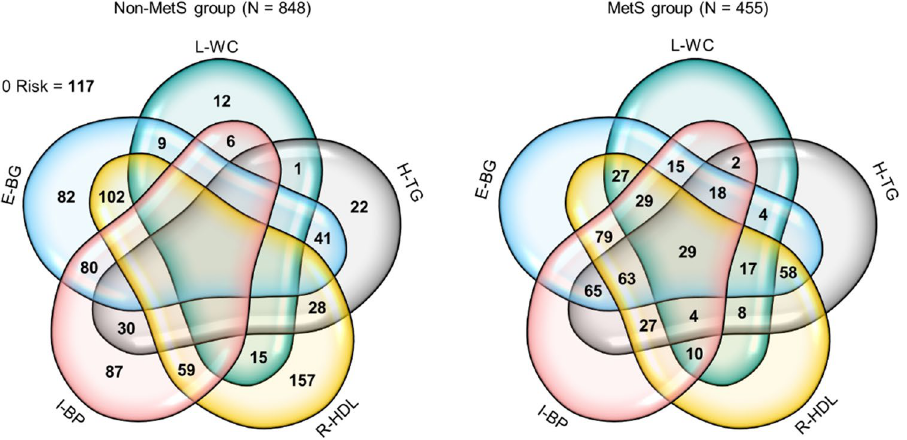
Figure 1. Venn diagrams showing the number of subjects in risk factor combinations of the Non-MetS and MetS groups.